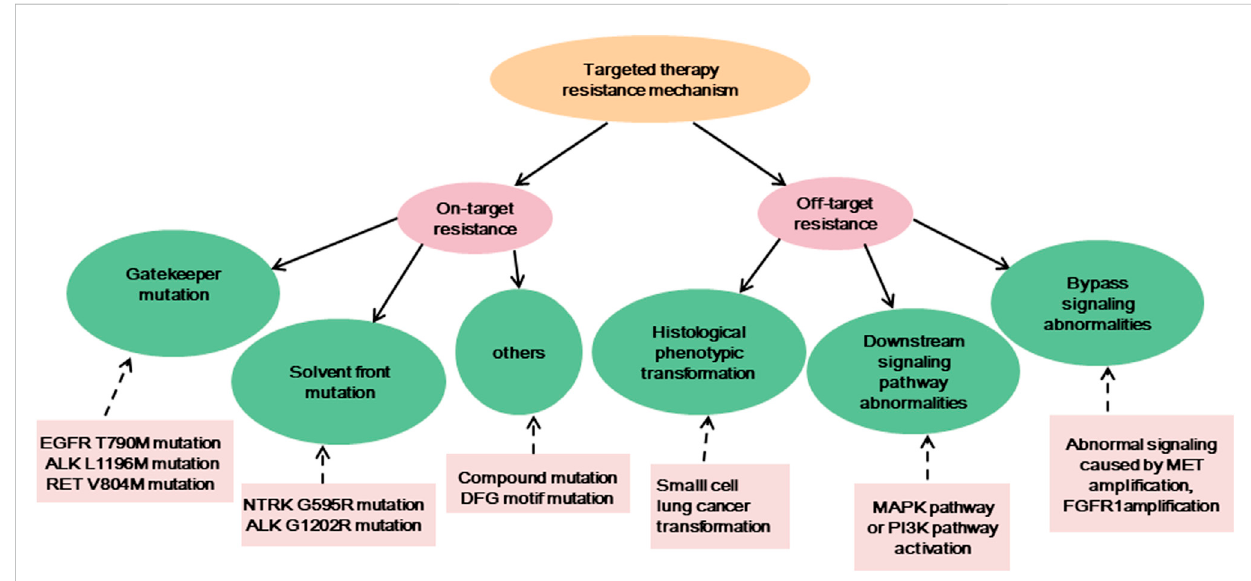
FIGURE 1 The resistance mechanisms of existing targeted therapies, and the examples of corresponding